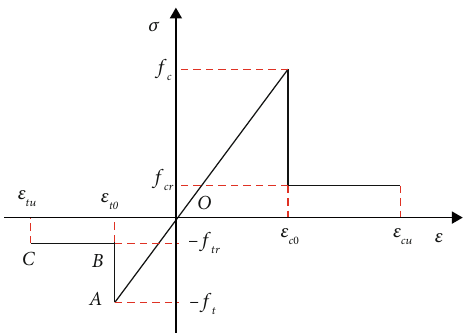
Figure 16: Mechanical behavior model of elements under uniaxial loading in RFPA 2D